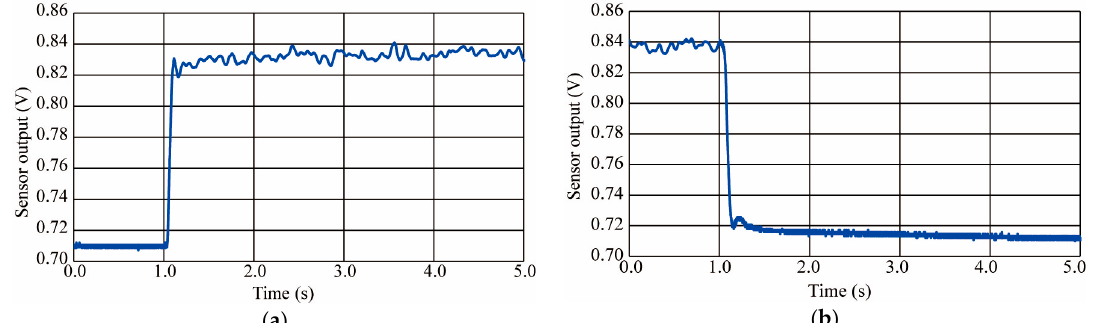
Figure 5. Responsive wave: ( a ) Rise time; ( b ) Fall time.